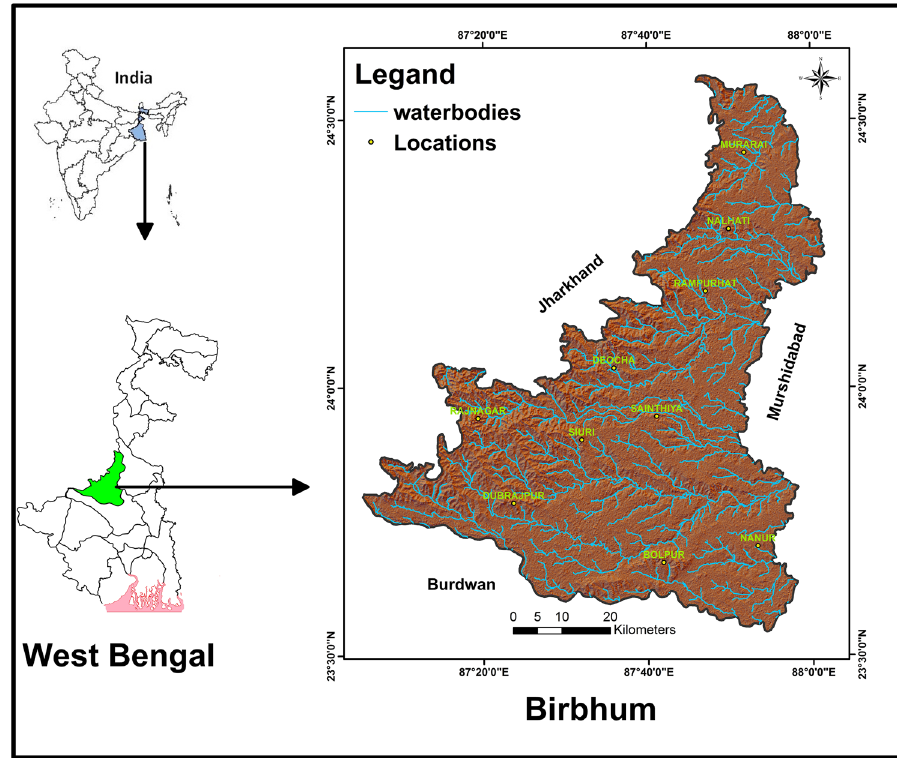
Fig. 1 Location map of